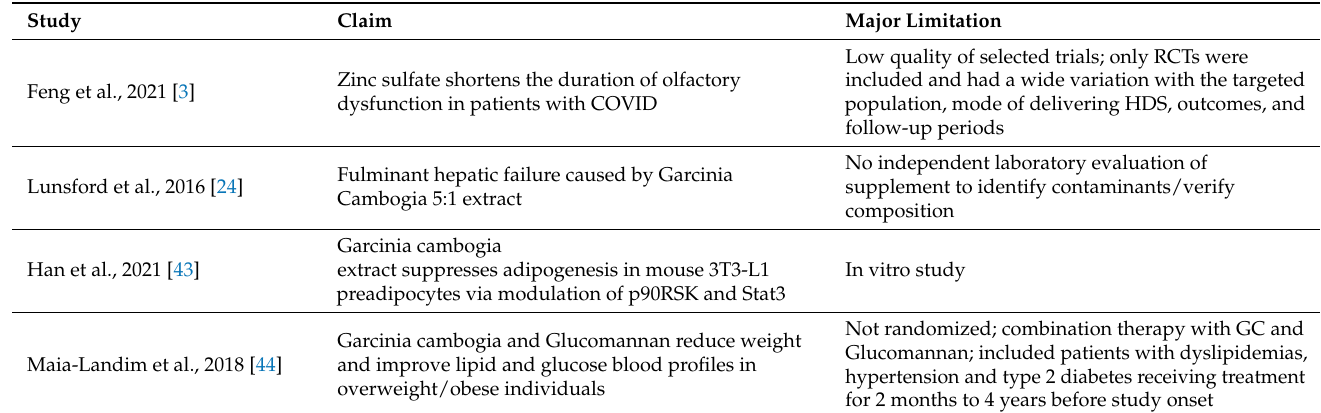
Table 3. List of individual studies and their